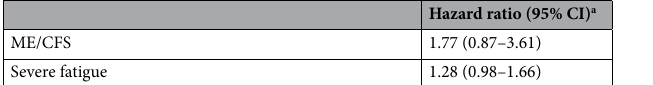
Table 4. Hazard ratios for ME/CFS and for severe fatigue after infectious mononucleosis. a Hazard ratios of ME/CFS (N = 40 cases) and of Severe Fatigue (N = 331 cases) developing in those with infectious mononucleosis compared to a referent group without infectious mononucleosis. Hazard ratios are adjusted for age, physical activity (quartiles), body mass index (BMI) (< 18.5, 18.5–24.9, 25–29.9, ≥ 30), and smoking status (never, past,